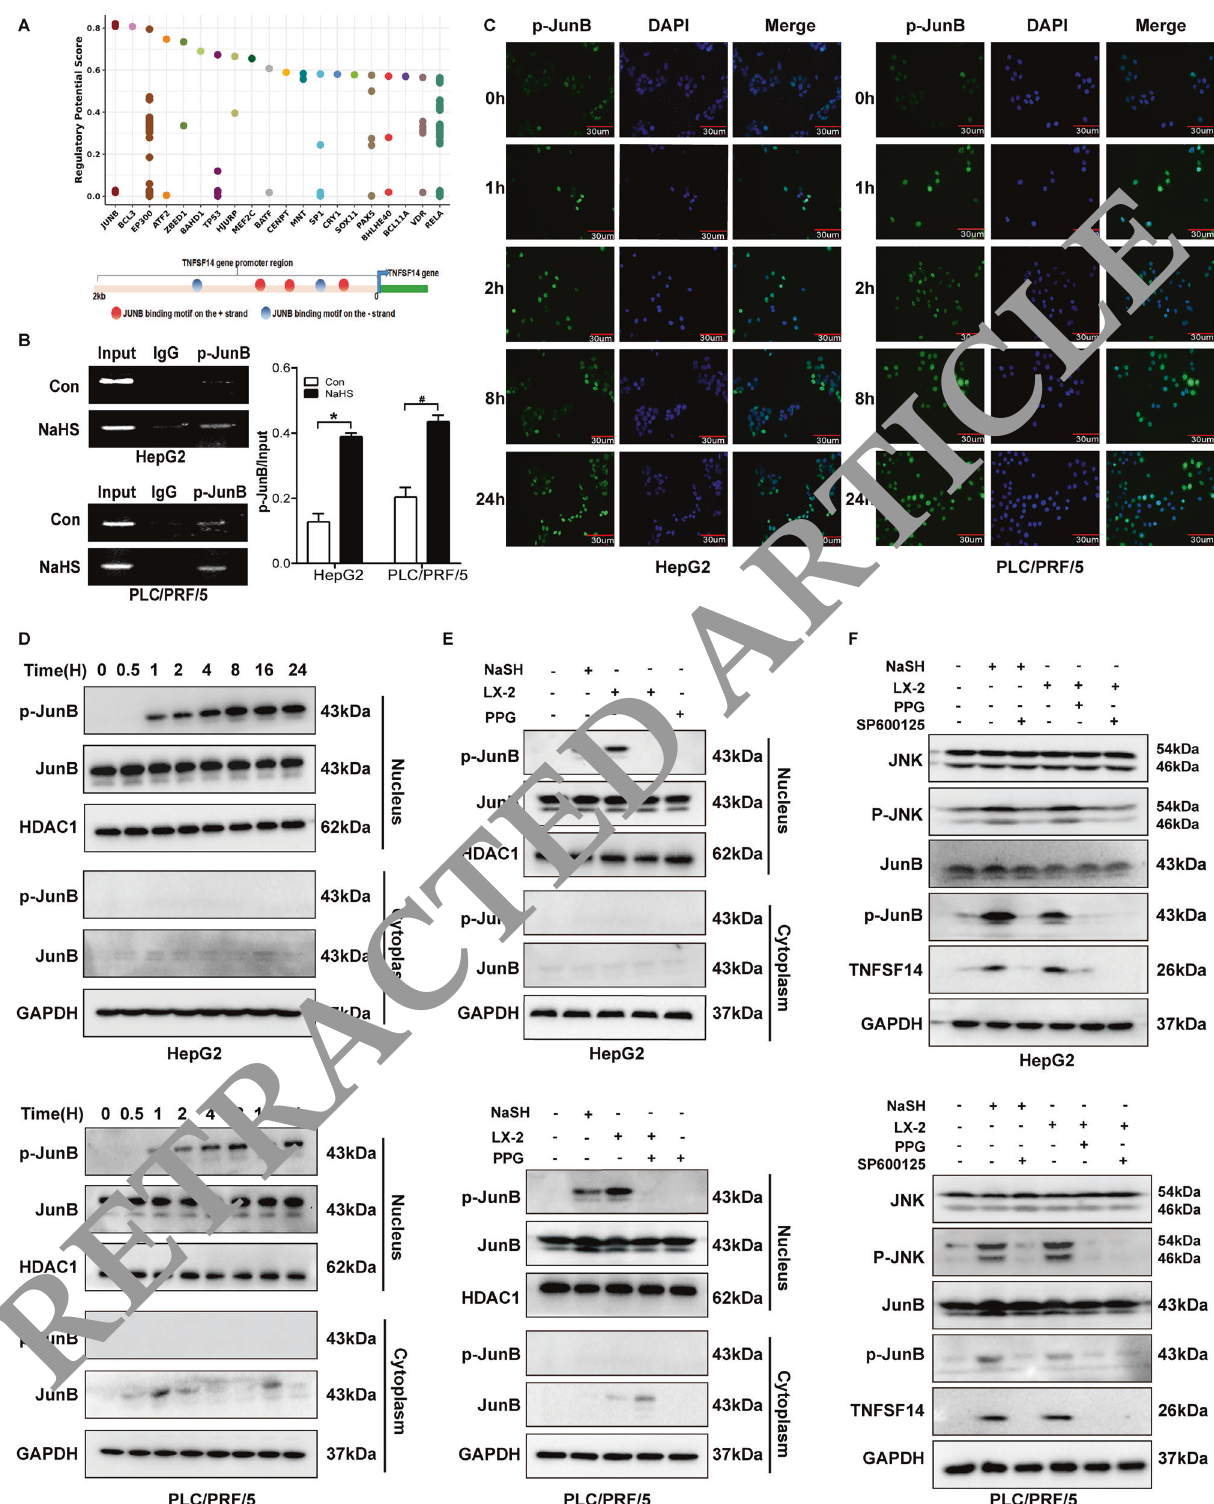
expression was knocked down (Fig. 4C, F). On the other hand, the effect of TNFSF14 was also con fi rmed through transfection of the tnfsf14 gene into HCC cells, which showed that transfection with pcDNA3.1-tnfsf14 results in apparent increase of apoptosis in HepG2 and PLC/PRF/5 cells with different treatments (Fig. S3). Cell Death and Disease (2022)